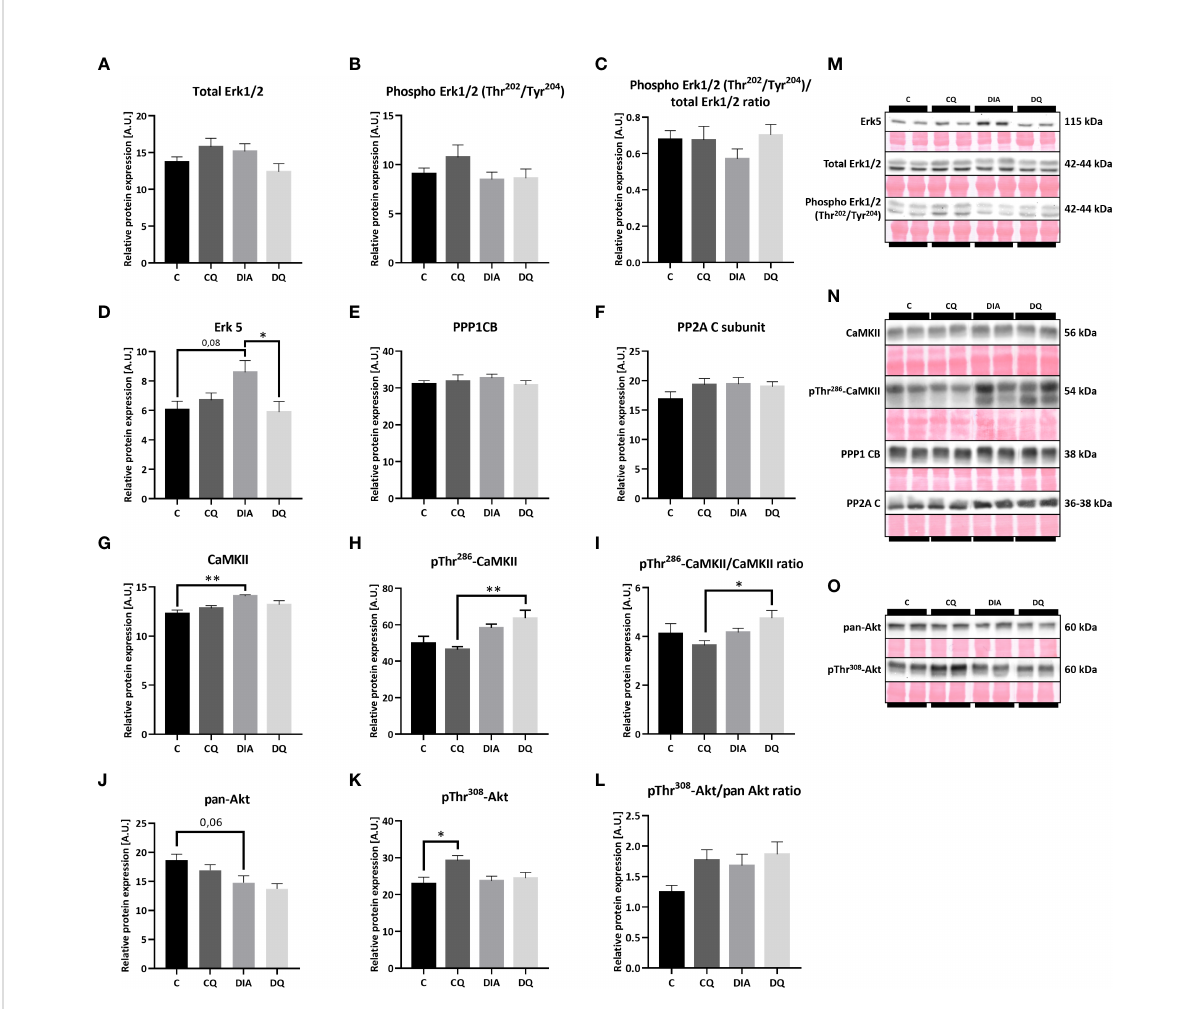
FIGURE 5 Western blot analysis of relative protein expression of (A) total extracellular signal-regulated kinase 1/2 (Erk1/2), (B) Phospho Erk1/2 (Thr 202 / Tyr 204 ), (C) Phospho Erk1/2 (Thr 202 /Tyr 204 )/total Erk1/2 ratio (D) extracellular signal-regulated kinase 5 (Erk5), (E) Protein Phosphatase 1 Catalytic Subunit Beta (PPP1CB), (F) Protein Phosphatase 2A C Subunit (PP2A), (G) calcium/calmodulin-dependent protein kinase II (CaMKII), (H) pThr 286 - CaMKII, (I) pThr 286 -CaMKII/CaMKII ratio, (J) pan-Akt (protein kinase B), (K) pThr 308 -Akt, (L) pThr 308 -Akt/pan Akt ratio, (M – O) Representative Western blots of detected proteins with estimated molecular weight (kDa) compared to total protein staining with Ponceau S. Data are presented as mean ± SEM and statistical differences as: * p < 0.05, **p < 0.01 (one-way ANOVA paired with Tukey´s multiple comparisons